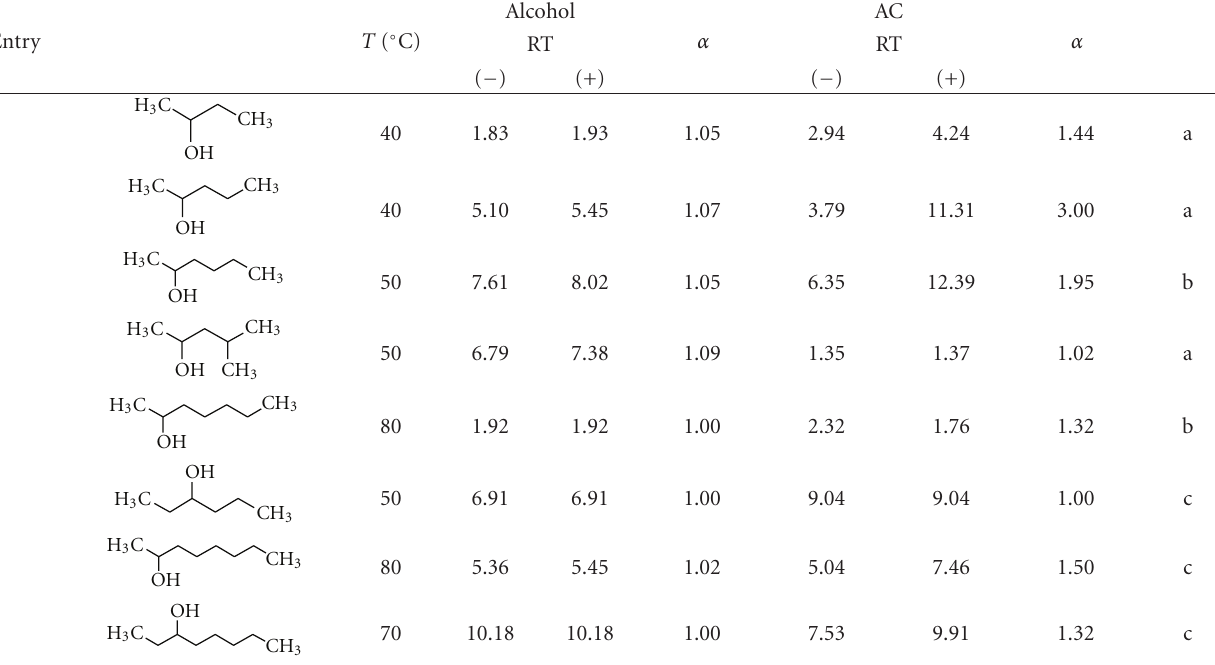
Table 4: Separation factor values ( α ) of the enantiomers of some acyclic alcohols and their corresponding acetyl derivatives.